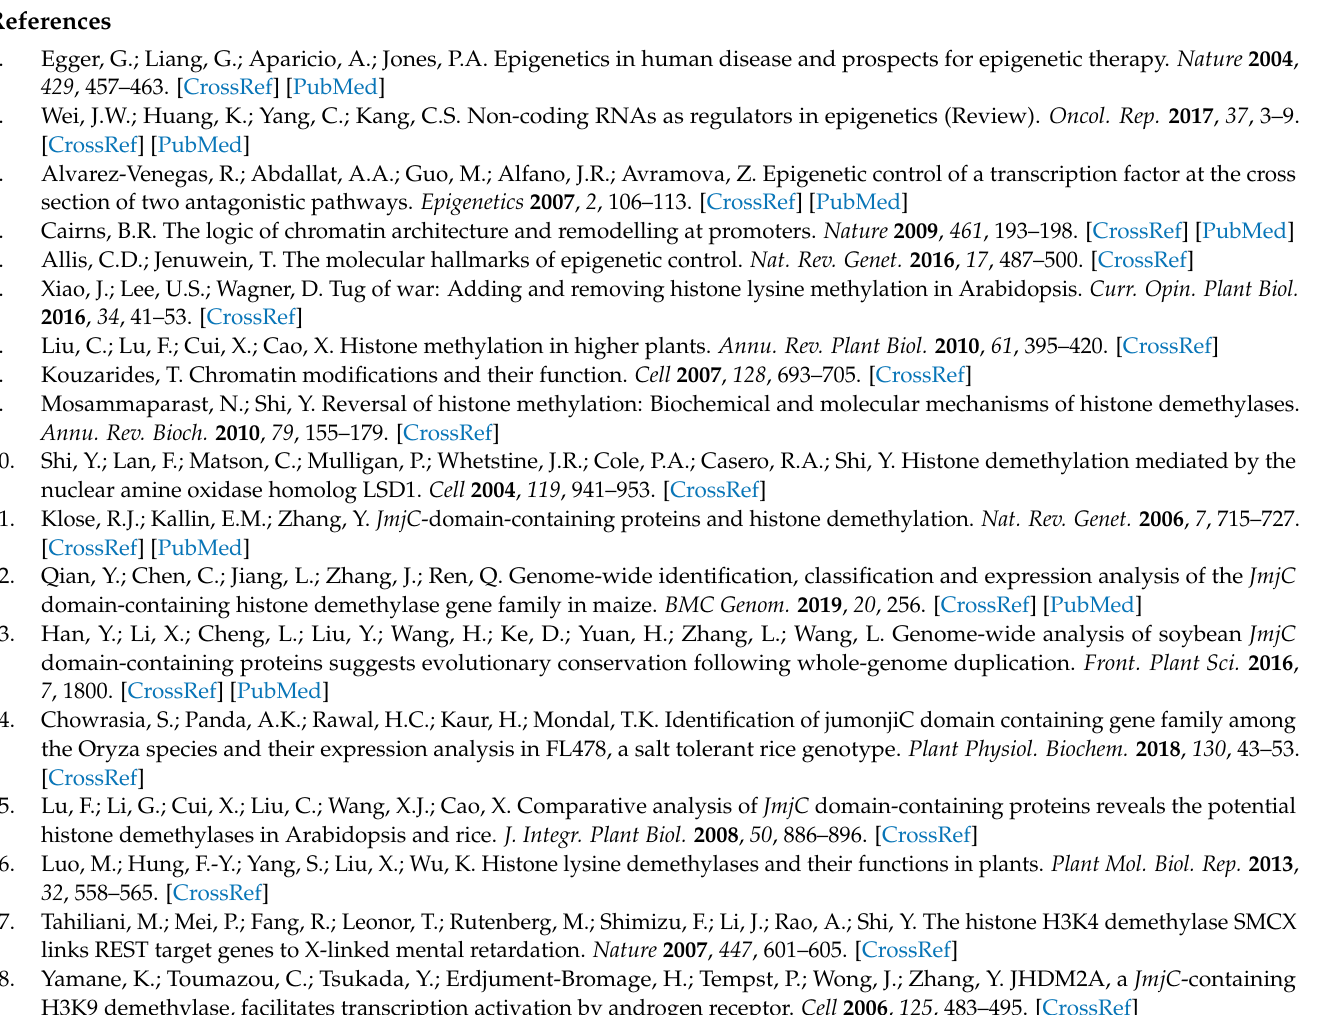
21 species; Table S2: Species selection and subfamily distribution in the plant JmjC gene phylogenetic tree; Table S3: JmjC gene family distribution; Table S4: List of identified cis-elements in the putative promoter region of JmjC genes; Table S5: The genome data sources for the species used in this study; Figure S1: JmjC gene family